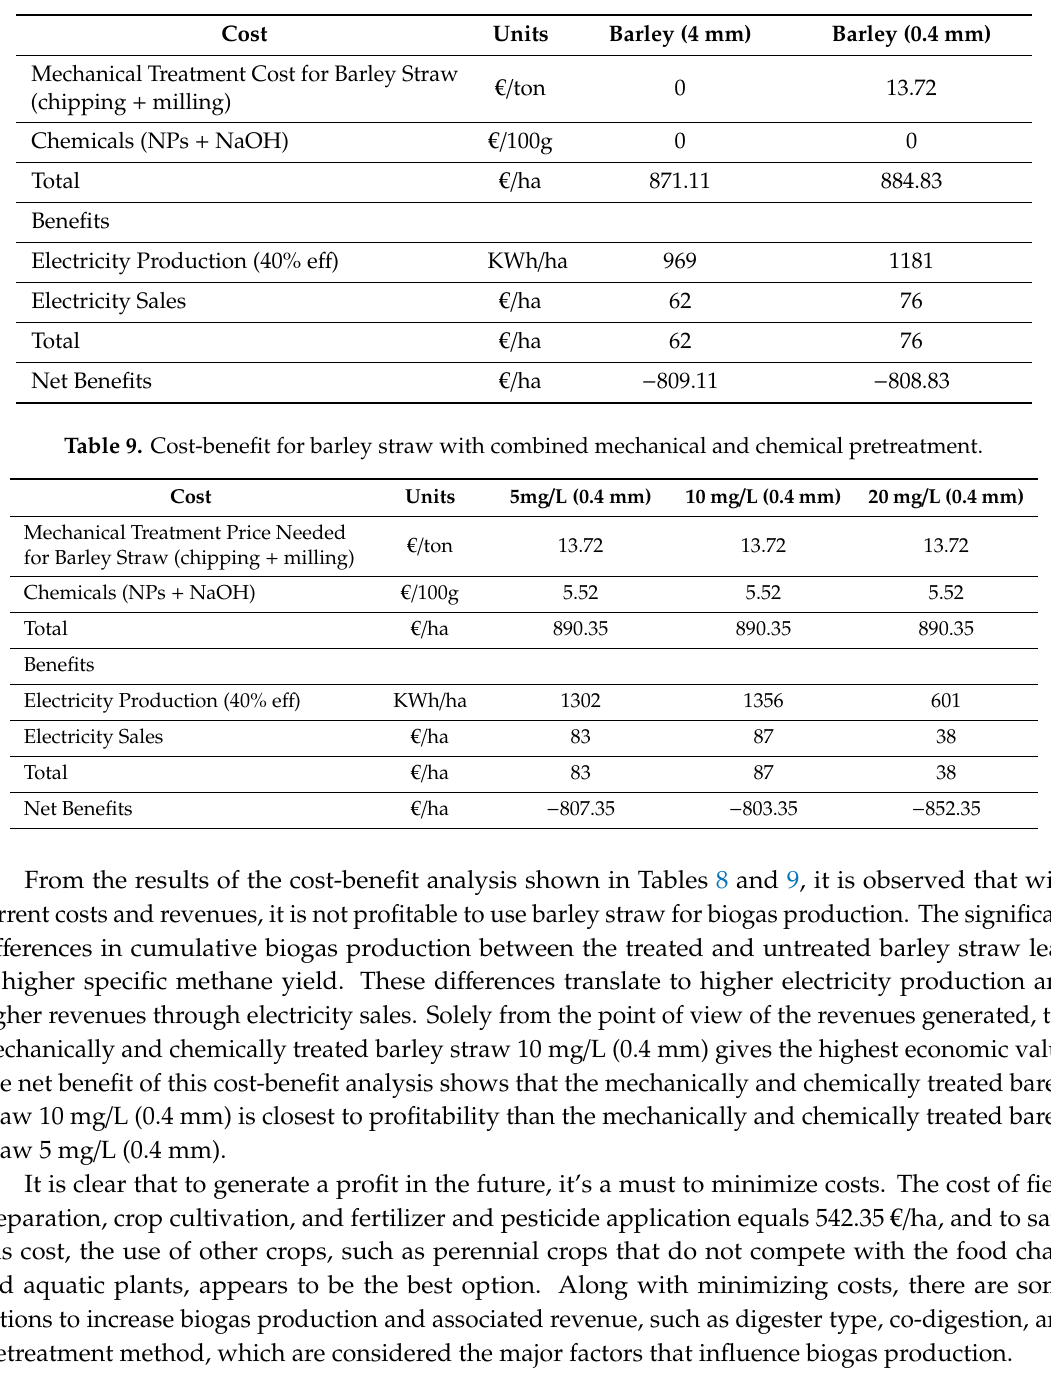
Table 8. Cost-benefit for barley straw with and without mechanical pretreatment.